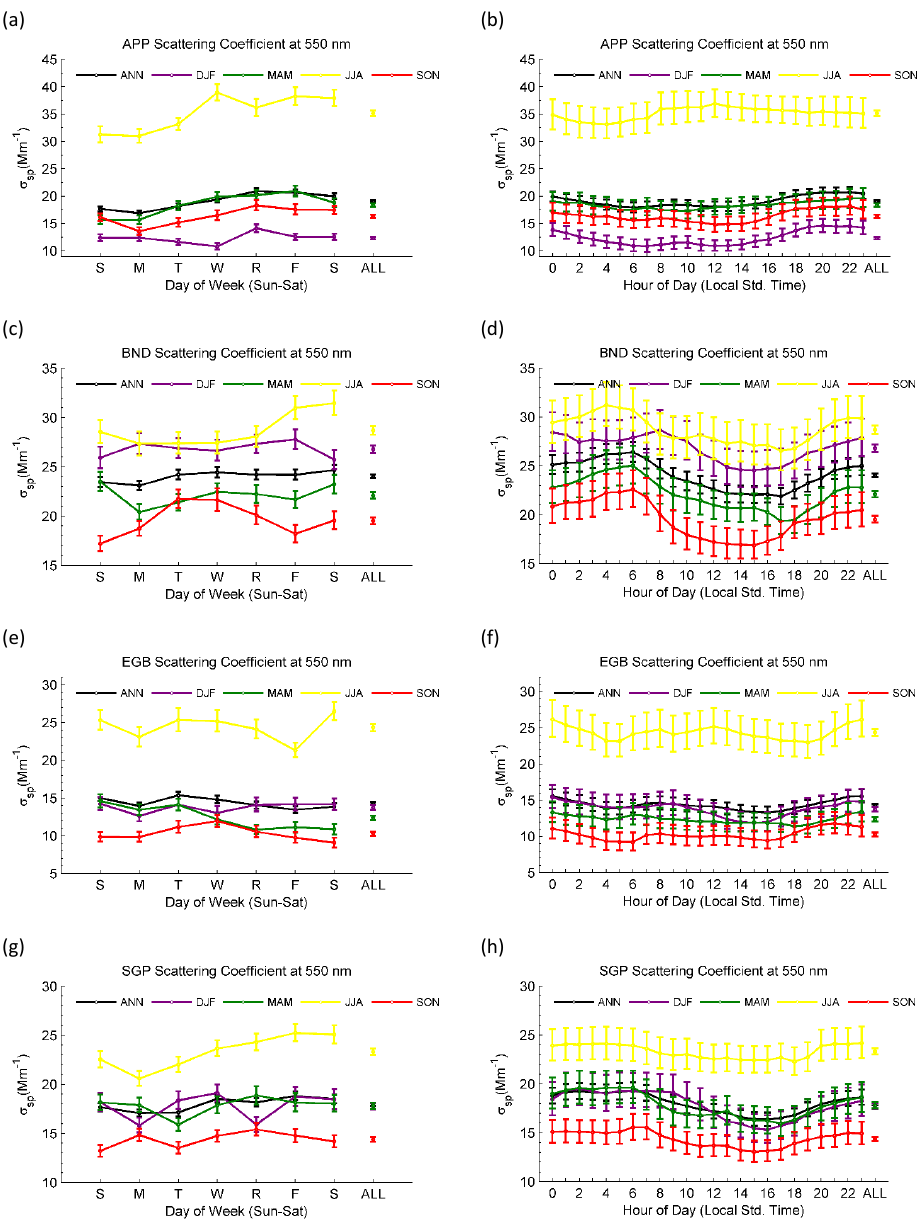
Figure 3. Weekly and diurnal cycles of geometric mean PM 1 σ sp over full years (ANN traces) and for winter (DJF), spring (MAM), summer (JJA), and fall (SON) at APP, BND, EGB, and SGP over the 2010–2013 period. The value corresponding to the “ALL” data point of each trace is the mean value over all days of the week or over all hours of the day. Error bars represent 95% confidence intervals of mean σ sp